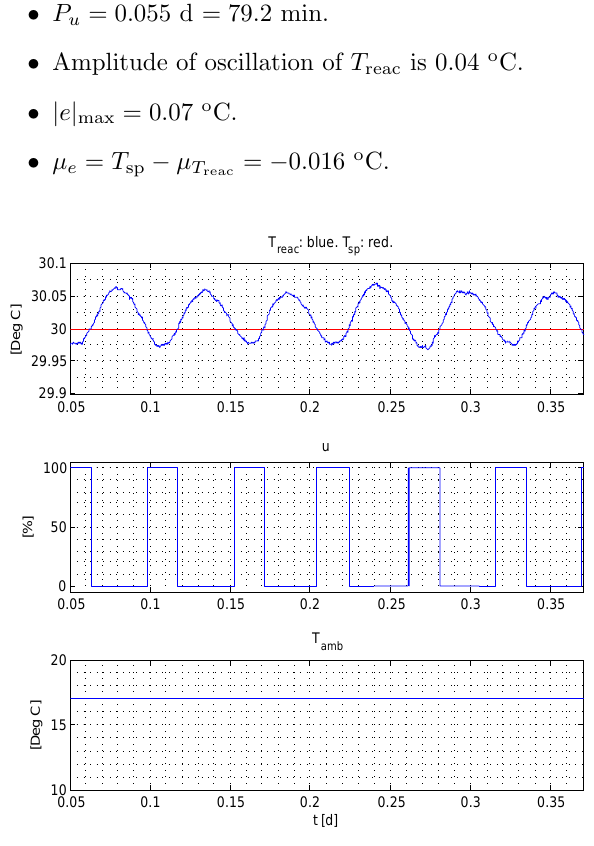
Figure 4: Simulated time-series for the reactor with on- off temperature control. Random measure- ment noise is